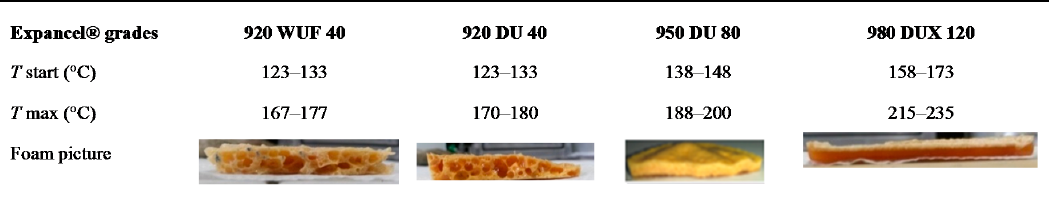
Figure 14. Expansion temperature data of microspheres and pictures of expandable microspheres/ epoxy formulation foams cured at 180 °C.